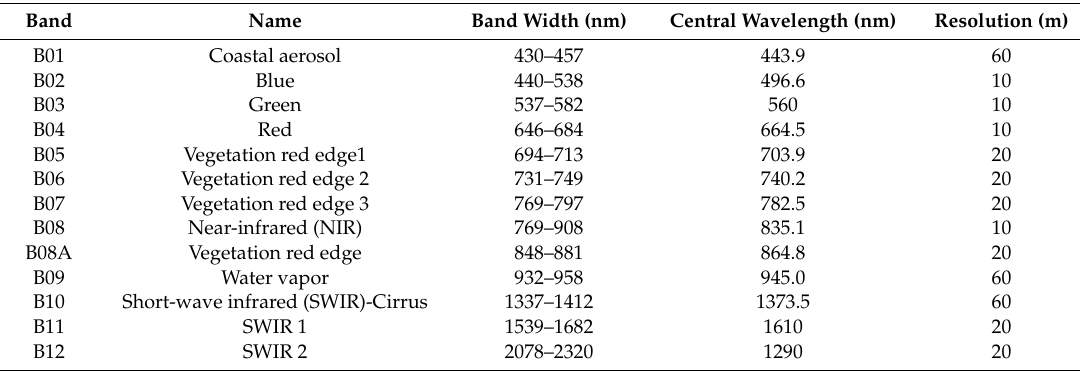
Table 1. Sentinel-2 satellites data band